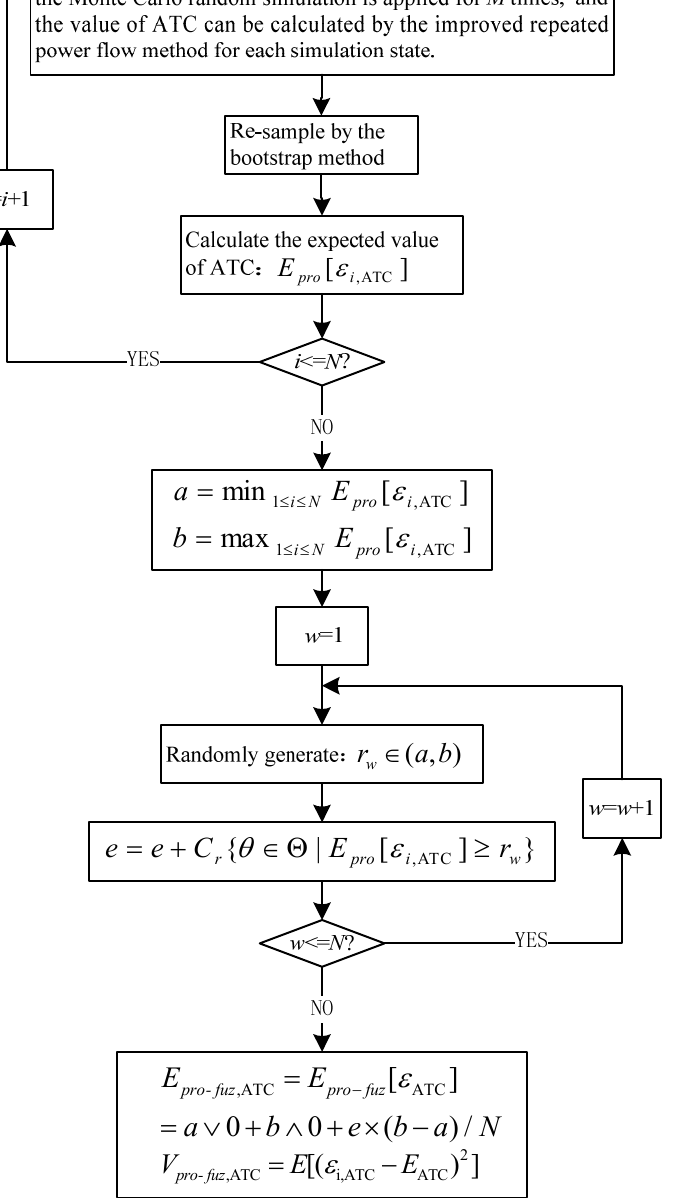
Figure 1. The flowchart of ATC